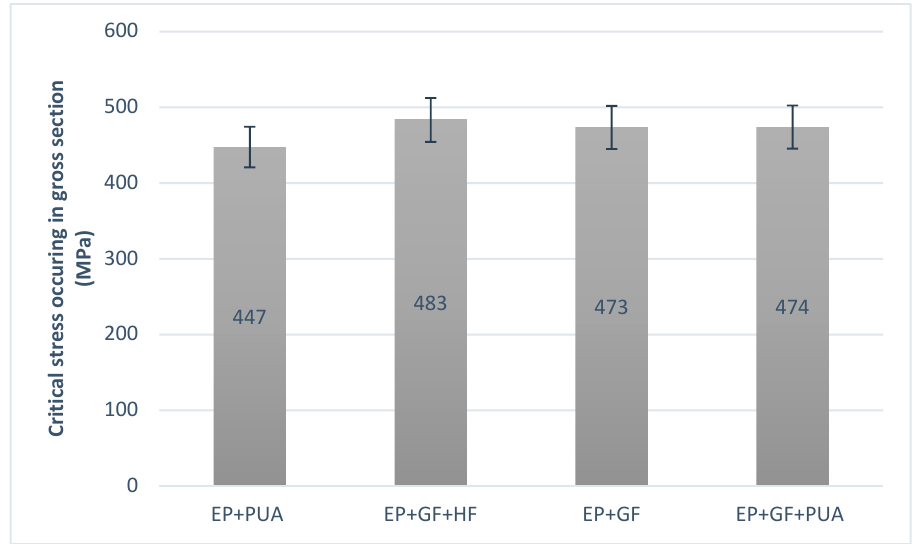
Figure 8. Comparison of the failure load during static tensile test.